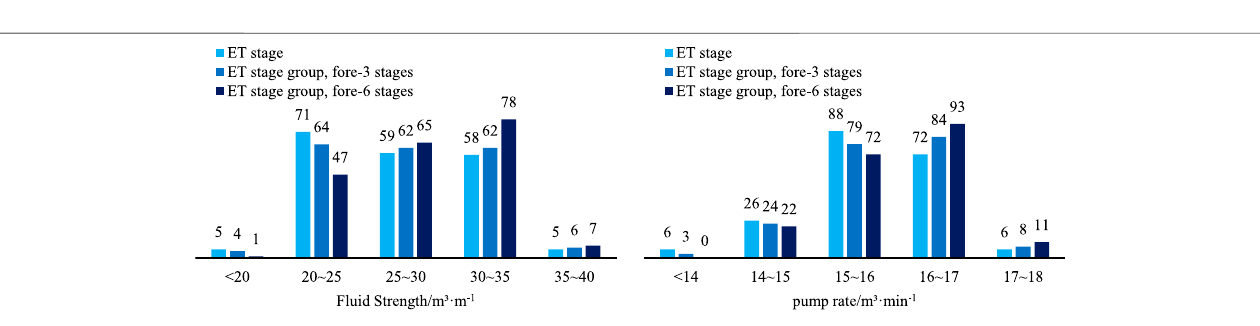
FIGURE 12 | Comparison of liquid strength and displacement in ET stages and ET stage groups.